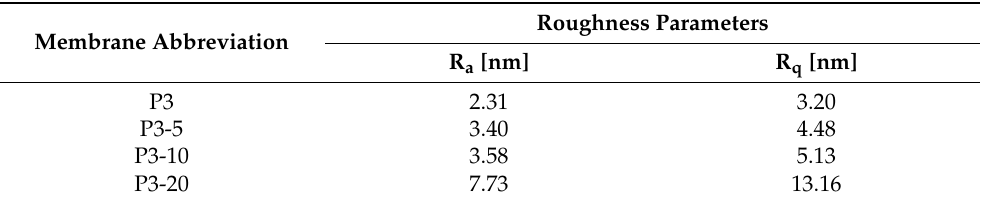
Table 5. Surface roughness parameters of the selective layer surface of TFC and TFN membranes prepared using physical adsorption.